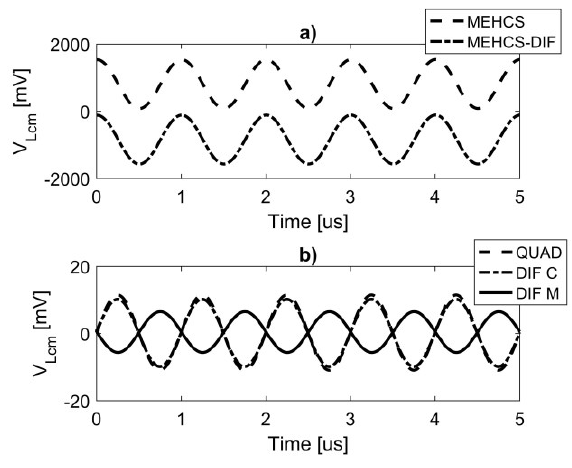
Fig.20: Simulated common mode load voltage ( V Lcm ) of the mirrored group and proposed group at time domain in 1 MHz with unmatched control resistors ( r and r x ).